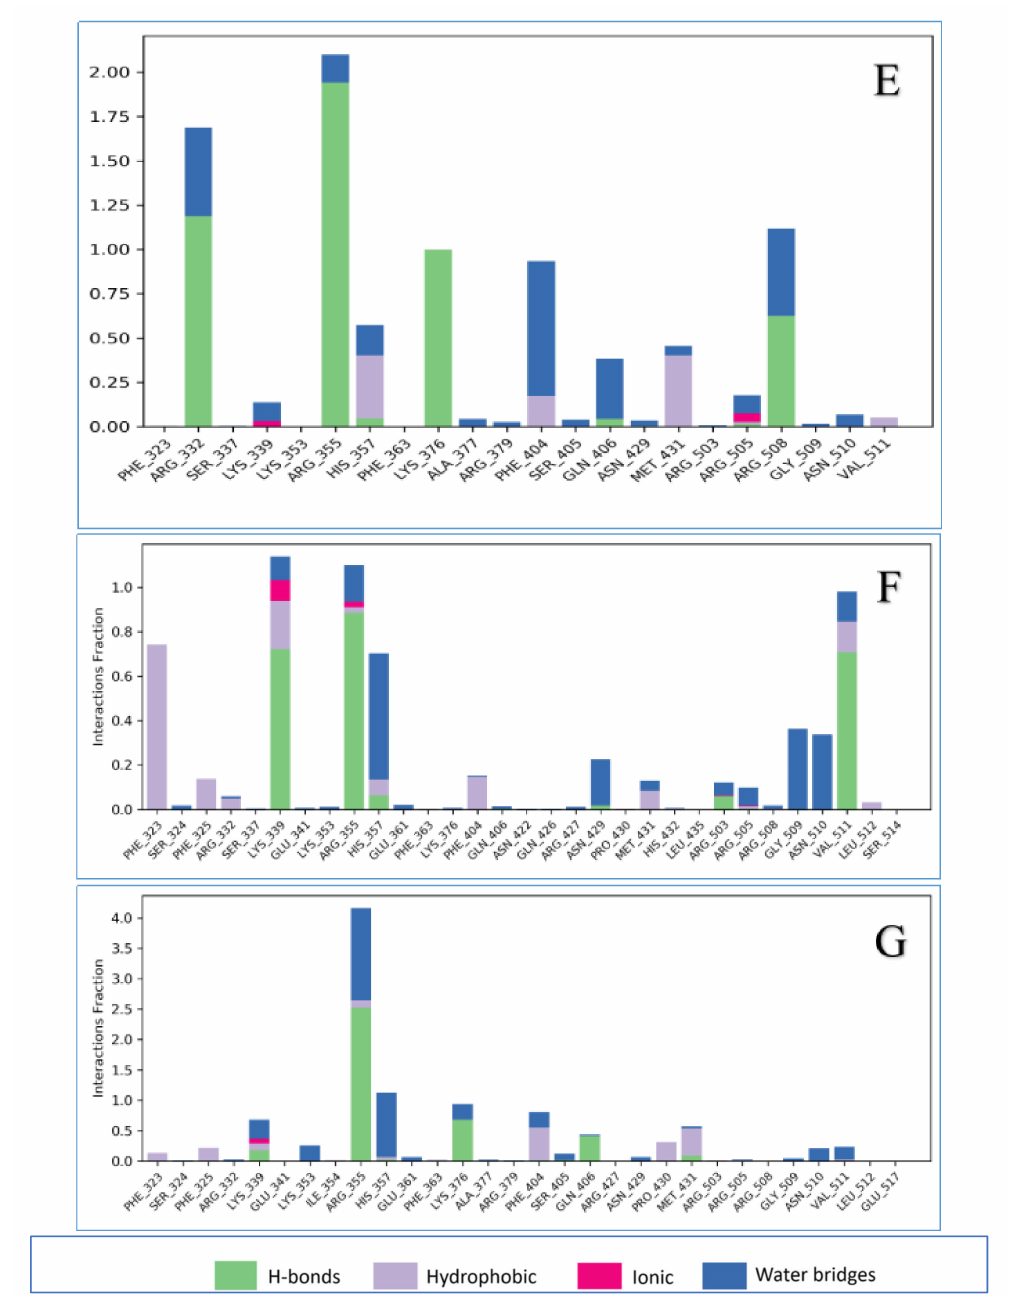
Figure 5. Interaction fraction summary of PB2–ligand contacts. Graph is normalized for the total simulation time. Interaction-fraction values over 1.0 indicate that the residue has multiple contact routes for interacting with the ligand. Shown are the interaction fractions for ( A ) VX-787 with PB2; ( B ) Str1614 with PB2; ( C ) Str1916 with PB2; ( D ) Str3107 with PB2; ( E ) Str5776with PB2; ( F ) Str6318 with PB2; and ( G ) Str7374 with